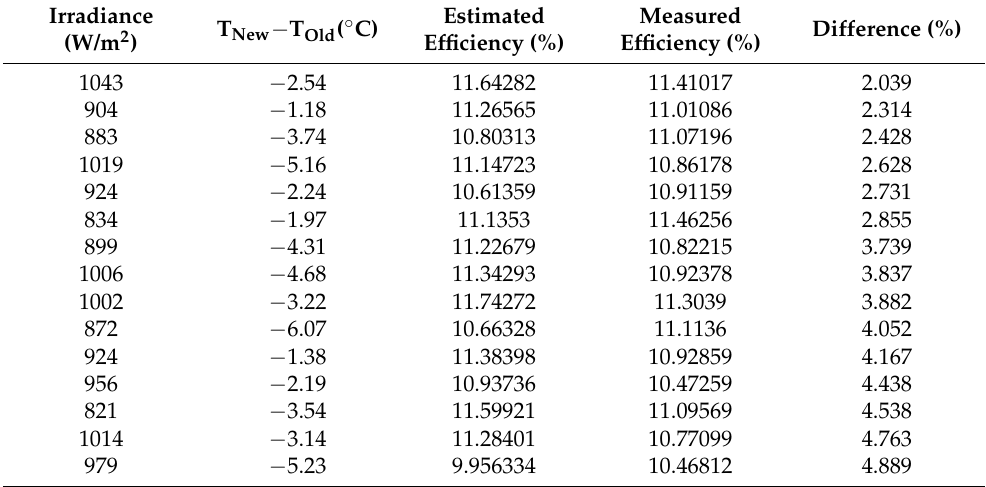
Table 7. Experimental results of efficiency estimation using the thermal imager onboard an UAV.